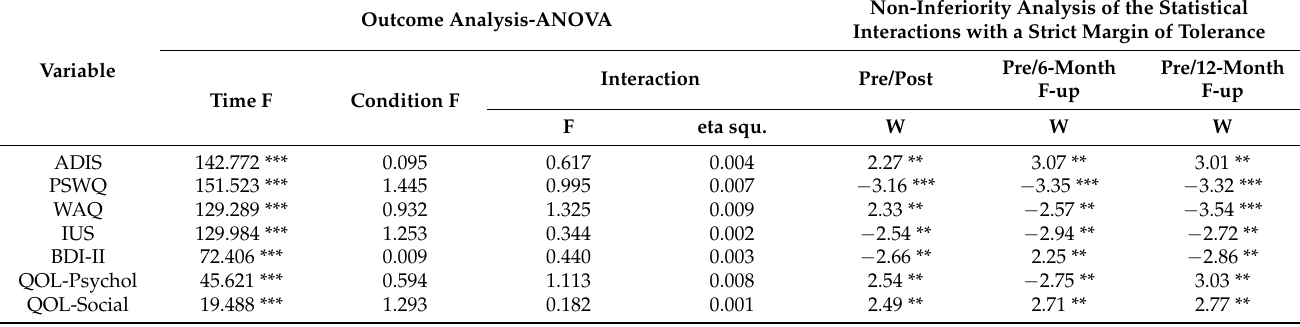
Table 3. Non-inferiority analyses of a RCT comparing the delivery of psychotherapy by videoconfer- ence or face-to-face to patients with generalized anxiety disorder (intent-to-treat) ( n = 148). Non-Inferiority Analysis of the Statistical Outcome Analysis-ANOVA Interactions with a Strict Margin of Variable